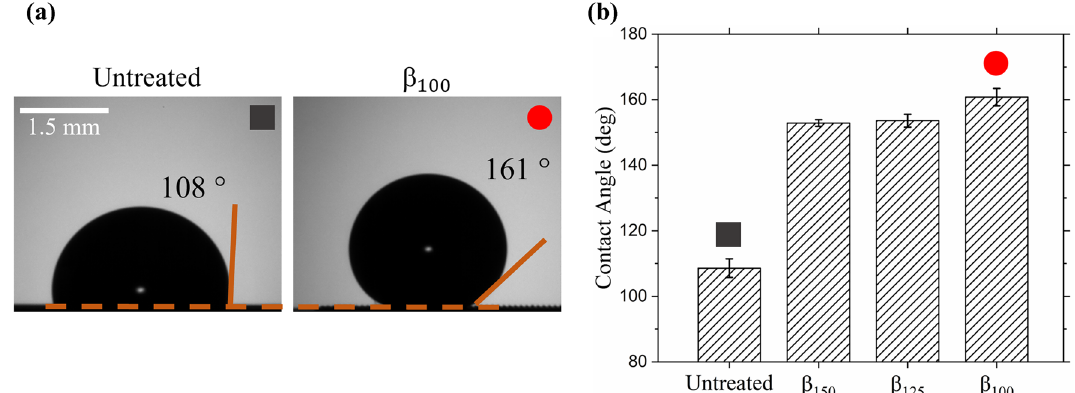
Figure 2. ( a ) Visual comparison of sensile DI water droplet on a smooth, untreated PDMS and on the β 100 microstructure sample. ( b ) Average of three contact angle measurements for each of the four samples casting. Figure 1b shows SEM images of each acrylic laser-scribed mold and their PDMS casted counterparts (below). The microstructure walls measure approximately 45 µm in height. As seen in the PDMS castings, small conical shaped peaks (~ 20 µm tall) are formed at the intersections due to the two-passes during laser ablation. A smooth PDMS sample (i.e. untreated) was fabricated using the same procedures, without a scribed pattern on the acrylic (not shown). To characterize the ability of the PDMS microstructures to entrap air pockets upon water submersion, we analyzed the wettability properties for each grid size and compared them to the untreated PDMS surface. The sensile water droplet (SD) method was used to measure the hydrophobicity relationship to grid size. Using a micropipette, a DI water droplet of 10 µL was carefully placed atop each sample until the droplet contacted the structured surface. The pipette was slowly removed such that the droplet remained on the sample without drop- ping. An image was taken immediately after, capturing the lateral view of the droplet on the surface as seen in Fig. 2a. The sample was then dried with compressed air before repeating the experiment two more times for an average value of three contact angle measurements for each sample. The contact angle was measured using ImageJ and taken at the three-phase line interface (air–water-PDMS). As seen in Fig. 2b, the untreated PDMS sample has the smallest water droplet contact angle of 108° ± 3° while decreasing the microstructure size, β, leads to an increase in contact angle. The smallest structure size of β 100 has the largest contact angle of 161° ± 3°, suggesting it is the most hydrophobic sample of the tested surfaces. The other microstructures, β 125 and β 150 , have contact angles of 154° ± 2° and 153° ± 1° respectively. Cavitation experimental setup and flow visualization. To observe the interaction between the entrapped air pockets (EAPs) in the PDMS microstructures and a cavitation event, we employed a Q-switched Nd: YAG laser emitting at 1064 nm (Continuum, Surelite SLII-10) to generate cavitation in deionized (DI) water. The cavitating laser was focused into a glass cuvette containing the DI water-immersed samples. The cuvette was placed on a 3-axis stage with a 10 µm resolution to allow for precisely varying the cavitation stand-off distance. Each experiment was conducted with energies of approximately 1 mJ which provided 100% bubble formation probability per pulse and formed an average maximum bubble radius, R max , of 550 µm ± 9.8 µm (averaged over 5 events), lasting approximately 100 µs ± 5 µs. The average maximum bubble radius was obtained by generating cavitation bubbles 5 mm above the target samples which ensured spherical bubble formation. This obtained aver- age R max value represents the value for spherical bubbles and was used across all γ regardless of deviation from bubble symmetry at smaller stand-offs. This assumption of an “equivalent spherical radius” that is independent of γ has been made by other authors such as Brujan et al. 34 . The bubble interactions were captured using high speed (HS) shadowgraphy at 100,000 frames per second (fps) and 128 × 208-pixel resolution using a HS camera (Photron, Nova S6) coupled with a long-distance microscope (Infinity, KC VideoMax). The resulting resolution was approximately 19 microns per pixel. As shown in Fig. 3, an additional CCD camera was also mounted to provide a top view of the microstructures during experiments. A pulse delay generator (Berkeley Nucleonics, M-555) was used to externally synchronize and trigger the laser and HS camera up to a 1 ns resolution. To visualize the flow fields following the interaction between the entrapped air pockets and a cavitation bub- ble, tracer particles were suspended in the DI water for particle tracing velocimetry (PTV) analysis. PTV was performed separately, independent from the primary experiments. The particles used for PTV were fluorescent green polyethylene microspheres (Cospheric, UVPMS-BG, ρ = 1.00 g/cc, 27–32 µm diameter) with peak excita- tion and emission at 414 nm and 515 nm respectively. The particles were excited by a continuous wave (CW) captured the flow of the particles which was representative of the surrounding density-matched DI water. A long-pass filter (Thorlabs FEL0450) blocked the light from the CW diode such that the HS camera only captured the emission of the fluorescent particles and not reflection of the CW laser emission at 450 nm. Figure 3 shows a schematic of the main components in the experimental setup as described.